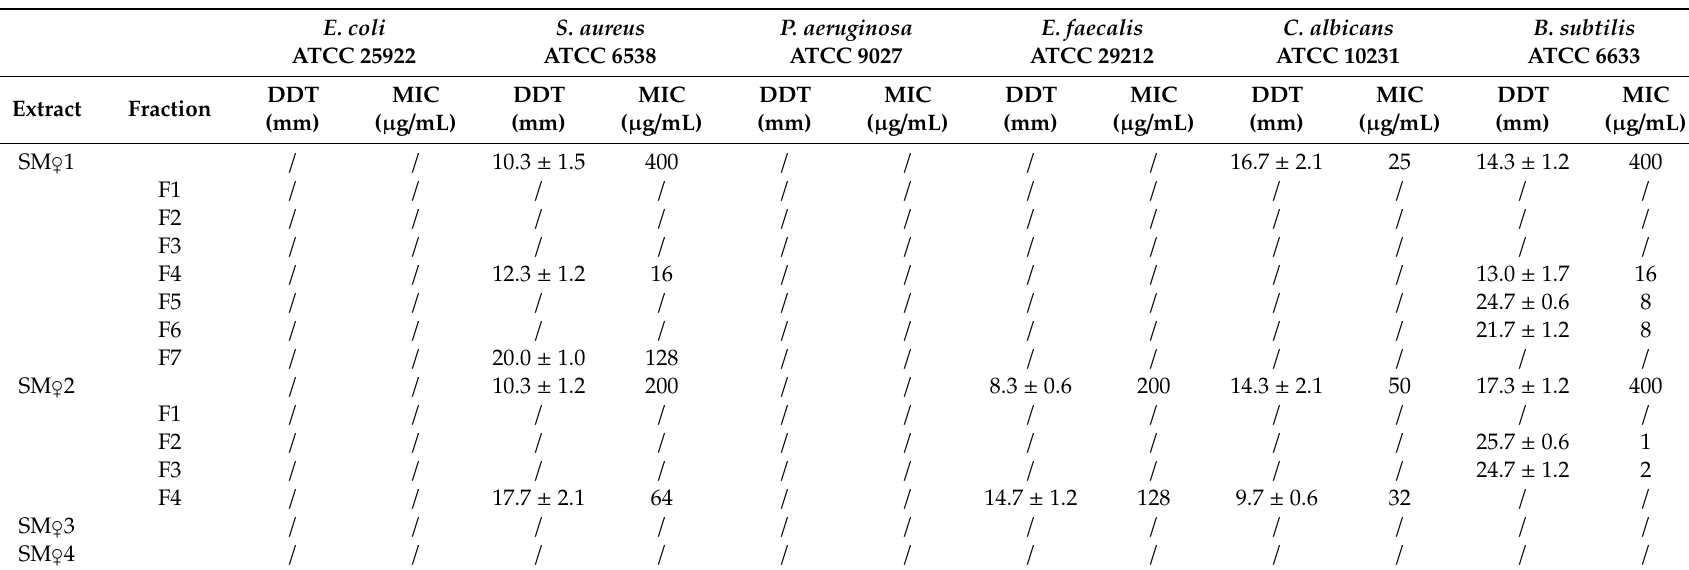
Table 1. Disk Di ff usion Test (DDT) and Minimal Inhibitory Concentration (MIC) of S. molle (L.) leaf (from female plants), extracts and fractions ( p values ≤